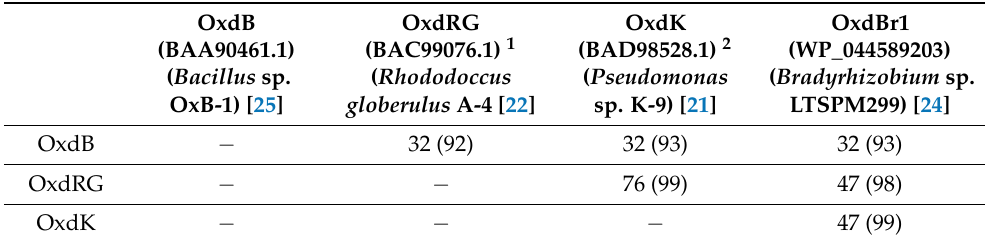
Table 1. Identities (approximated) between amino acid sequences of bacterial aldoxime dehydratases (according to [26]). Coverage % in brackets.